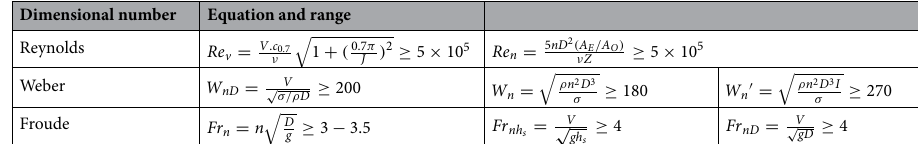
Table 1. Equations & ranges of dimensionless numbers effective on SPP